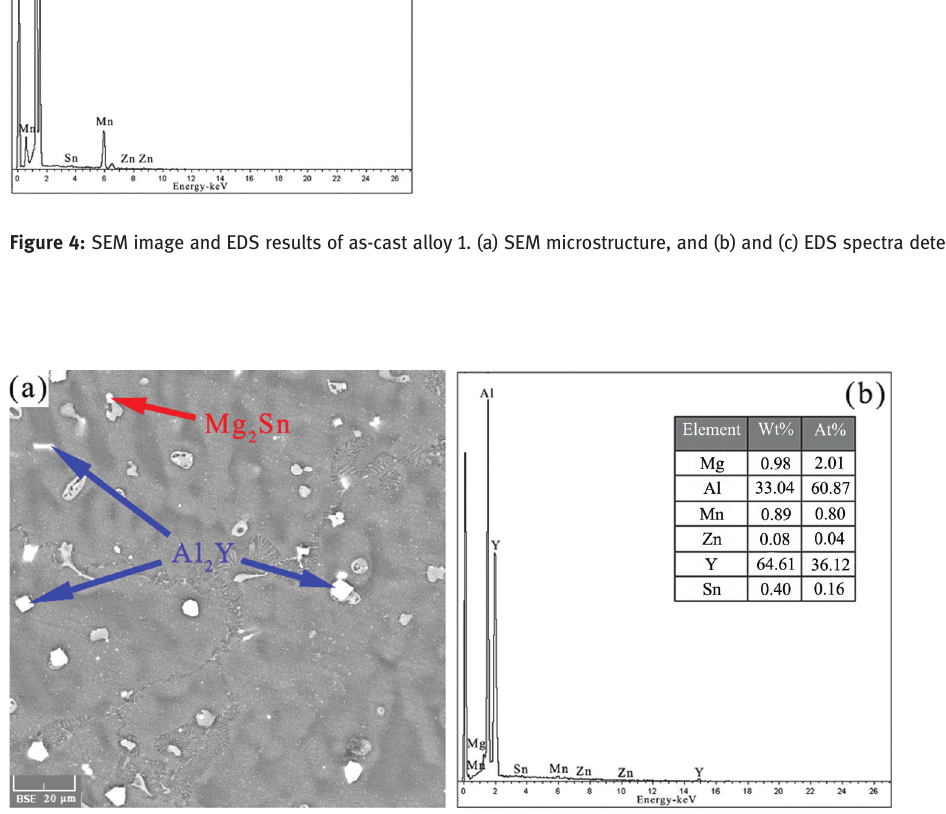
Figure 5: SEM image and EDS result of as-cast alloy 2. (a) SEM microstructure and (b) EDS result of Y-containing intermetallic